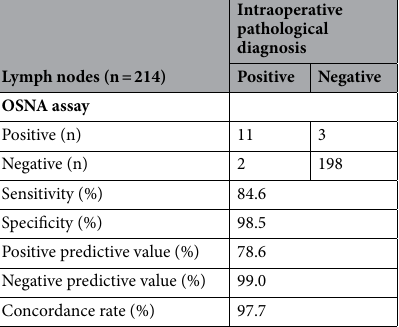
Table 2. Concordance between intraoperative pathological diagnosis and OSNA (number of lymph nodes).